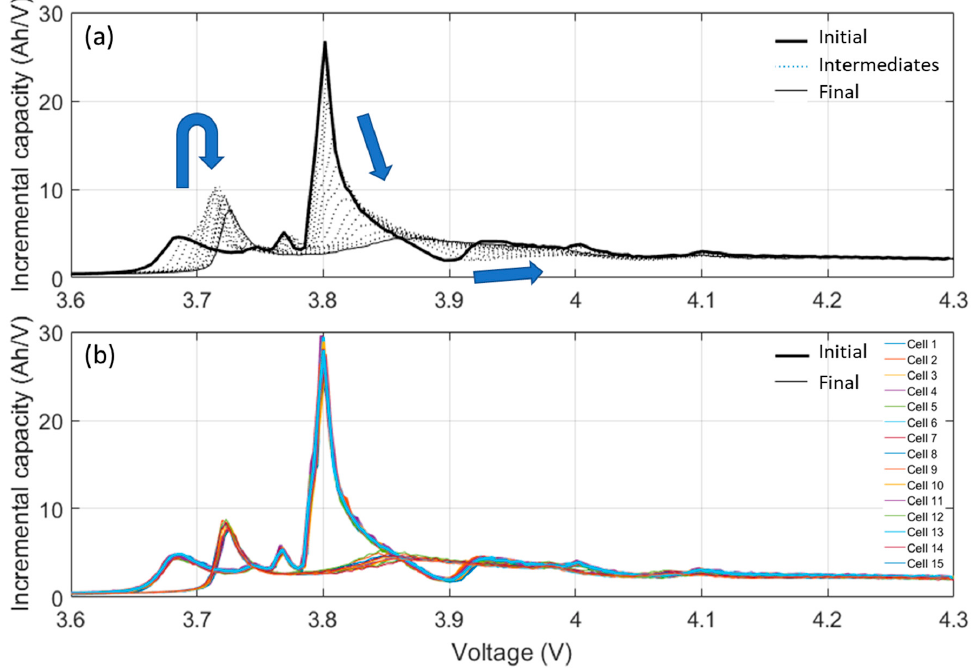
Figure 4. ( a ) Change in the voltage response at C/25 for cell #1 as a function of cycle number; ( b ) IC signature for all cells at the initial and final C/25 charge.